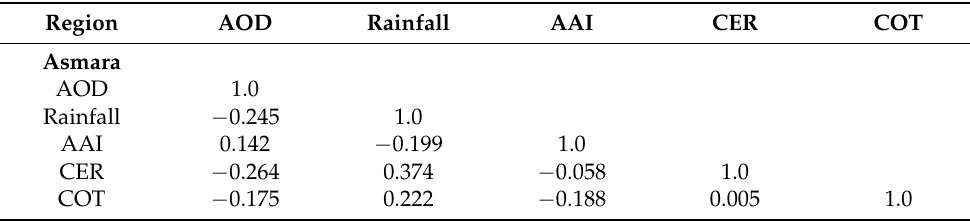
Table 4. The correlation coefficient values between AOD, rainfall, AAI, CER, and COT over Asmara in July between 2001 and 2018.